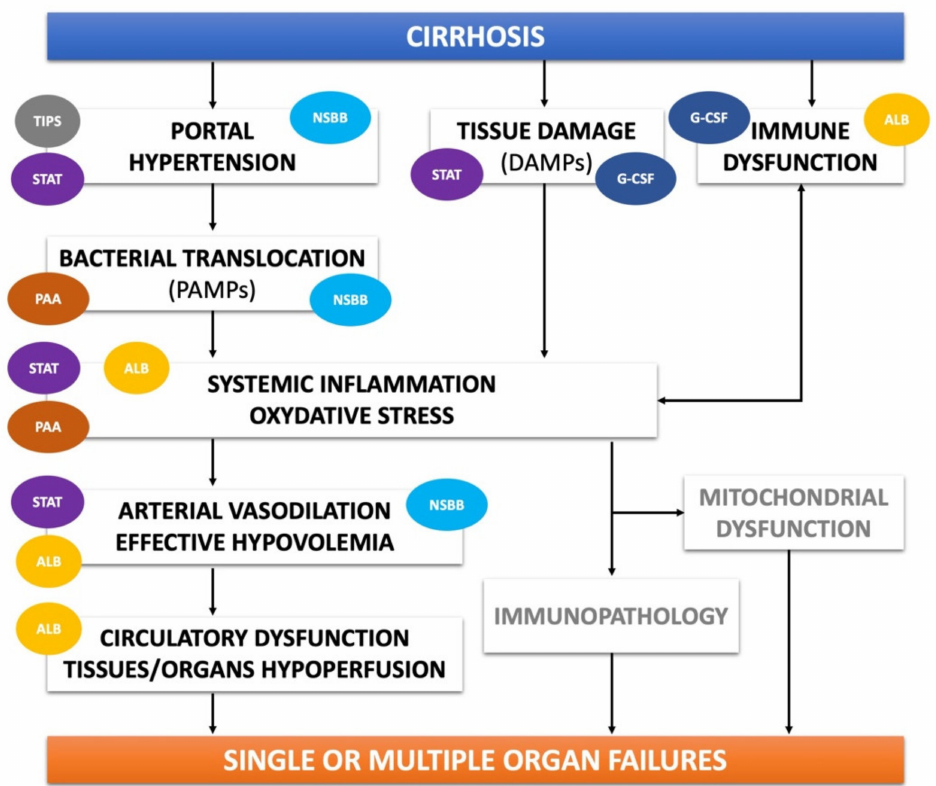
Figure 1. Targets of action of available treatments antagonizing key pathophysiological events in decompensated cirrhosis. See text for details. TIPS: trans-jugular intra-hepatic porto-systemic shunt; STAT: statins; NSBB: non-selective beta-blockers; G-CSF: granulocyte colony stimulating factors; PAA: poorly absorbable